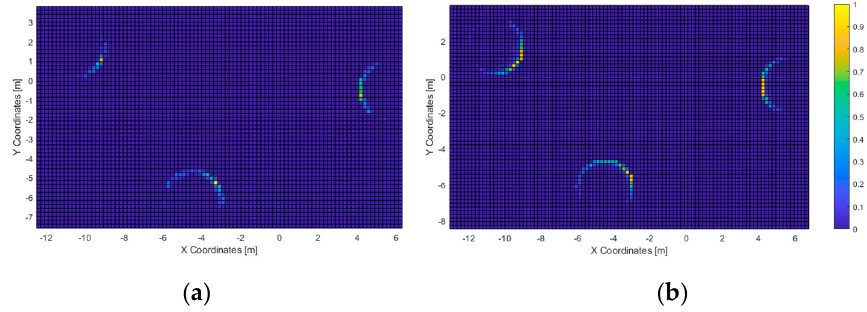
Figure 11. Test 1—Haptic ( a ) and acoustic ( b ) heatmaps. Spatial resolution: 20 cm. In the second test, 11 out of 23 subjects were able to exit the room (approx. 48%) within the time limit, with an average completion time of 136 s and a minimum of 75 s. The heatmaps of the most-travelled areas are displayed in Figures 12 and 13. Next, the heatmaps of the most-perceived elements are included in Figures 14 and 15.